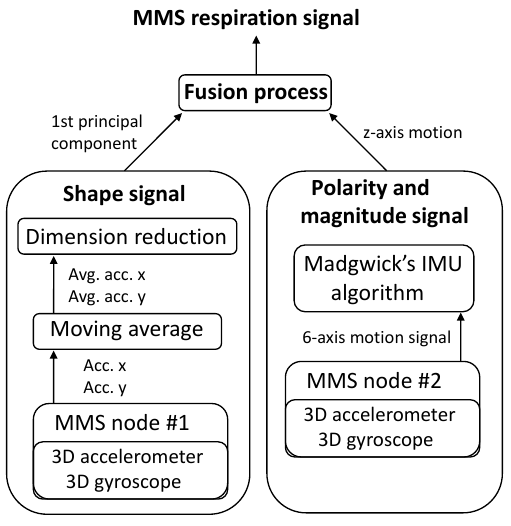
Figure 2. Flow diagram of the respiration motion estimation